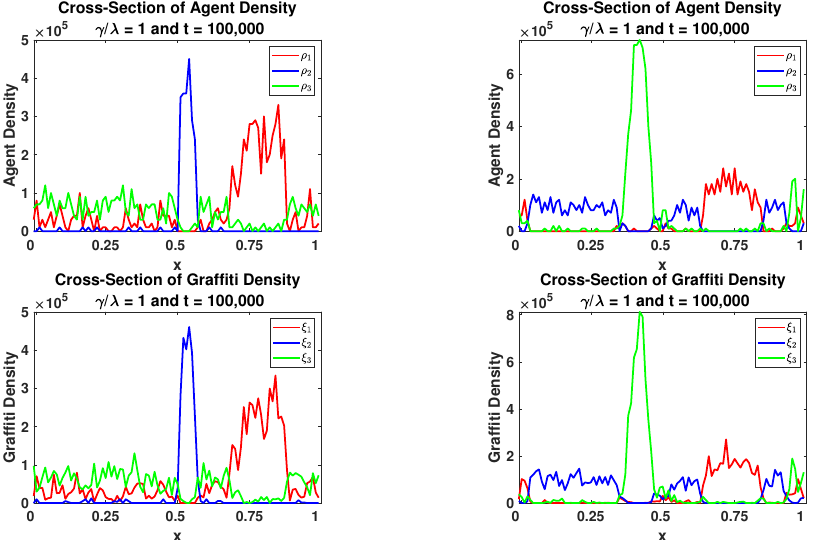
Figure 13. Cross-sectional slices of the agent and graffiti densities for different β extensions at the final time step for a segregated state. Here, we have N 1 = N 2 = N = 3 = 50,000 with δ t = 1 and the lattice size is 100 × 100; in both simulations, β 1 = 2 × 10 − 5 , β 2 = 3.5 × 10 − 5 and β 3 = 0.5 × 10 − 5 . ( Left ): Here, we consider the Timidity variation of the model. We observe that the territories range from small and very dense, with little incursion from the other gangs, to large and spread out, with other gang members encroaching on the territory, as the gangs’ β j value varies from high to low. ( Right ): Here, we consider the Threat Level variation of the model. We see that the size of the territory here is correlated with the β j value for the gang, and that all of the territories here seem well-defined, with little of the territorial encroachment seen in the model pictured on the